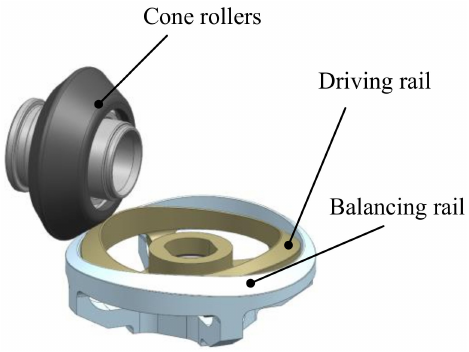
Figure 4. Structure of the new 2D motion-converting